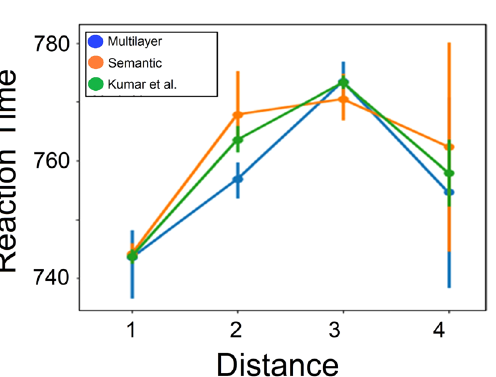
Figure 4. Comparing the distances of the semantic, phonological and multilayer networks as a function of the strength of the semantic links. ( A ) We compared the mean distances of the phonological network (P), the semantic filtered network (S), a multilayer composed of phonological and semantic filtered layers (M), and a random network with the same degree (R). All four networks consisted of the same set of nodes and have the same average degree. ( B ) Density plot of pairwise distances of the phonological network and the semantic network of top percentile of strongest semantic links. Note that the semantic network has typically longer distances than the phonological network. ( C ) Density plot of distances of the phonological network and the semantic network of the top 90% of strongest semantic links. Note that semantic network has typically shorter distance. ( D ) Comparison of the fraction of inter-links (inter community links) of the semantic network as a function of the semantic strength for the semantic (S), phonological (P) and random (R) networks. We found that phonological links and weak semantic links tended to be inter-community links more than strong semantic links, which explains the distance effect of the groups. ( E ) The average distance of the multilayer phonological- semantic network for different percentages of top semantic links (99%, 96% and 93%) as a function of the fraction of the semantic links. While in ( A ) we measured only the case of 50%, here we tested different fractions and we found that the minimal (optimal) average distance in the multiplex network of stronger semantic links was obtained for larger fractions of phonological links.